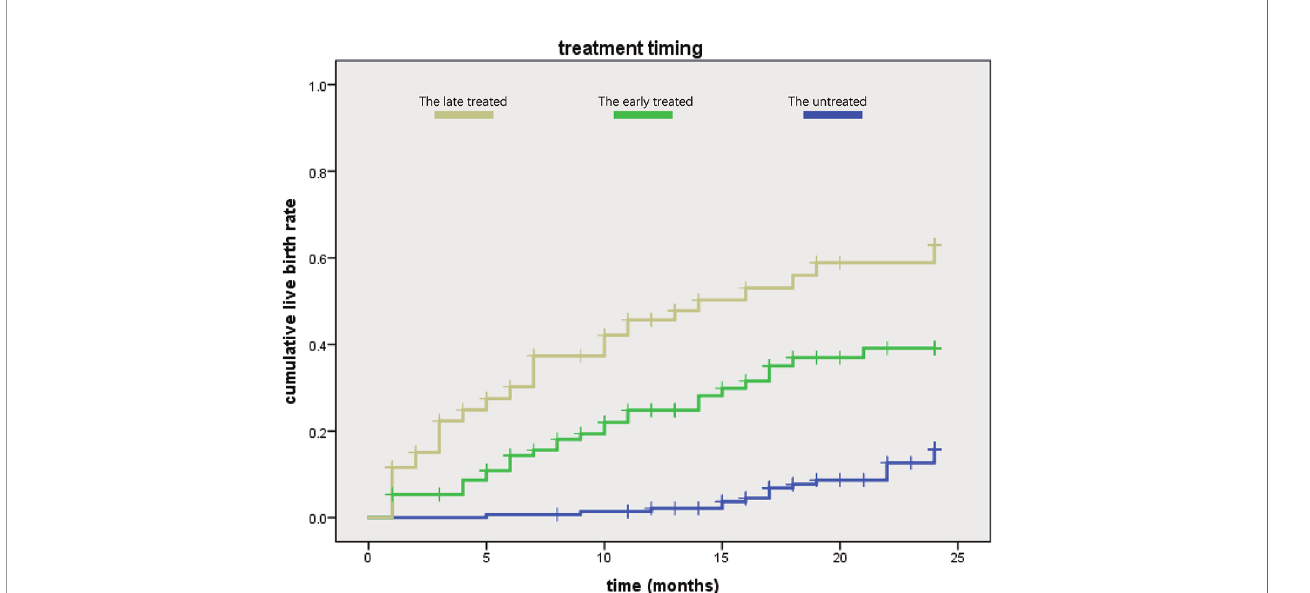
FIGURE 2 | Comparison of the three groups in cumulative live birth rate. The late-treatment group is shown in yellow color, the early-treatment group is shown in green, and the untreated group is shown in blue. We found that the late-treatment group had higher cumulative live birth rate than the other two groups, while the cumulative live birth rate of the untreated group was lowest according to treated time.